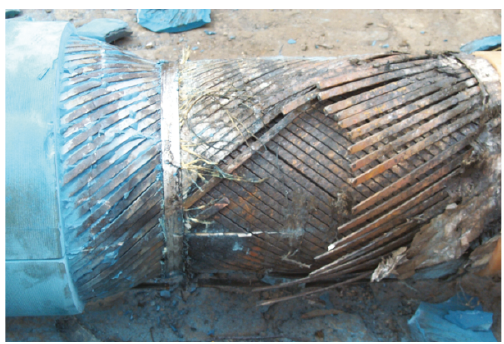
Figure 3: End-fitting failure example.